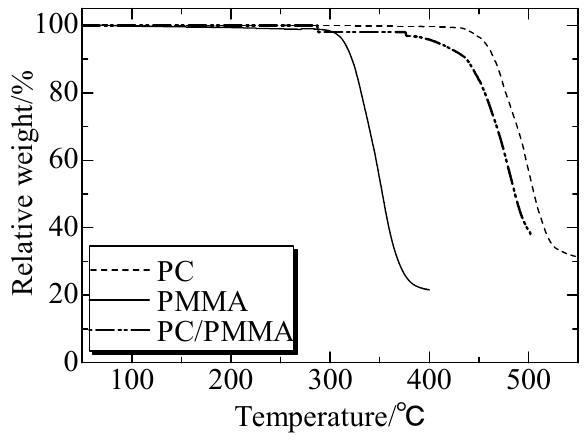
Figure 14. TG test of PC, PMMA and PC / PMMA. Adapted from Reference [149].